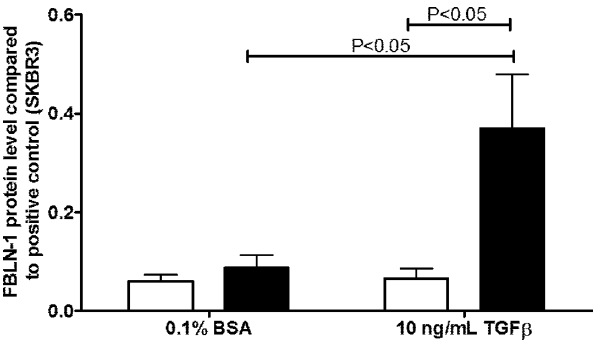
Figure 3. TGF b induced FBLN-1 protein in asthmatic ASM cells. FBLN-1 protein was detected by western blot following TGF b stimulation for 24 h of ASM cells collected from non-asthmatic (white bars, n=4) or asthmatic (black bars, n=4) volunteers. Data were normalized to the house keeping protein GAPDH and are expressed relative to a positive control of the cell line SKBR3. Data are expressed as mean 6 SEM.